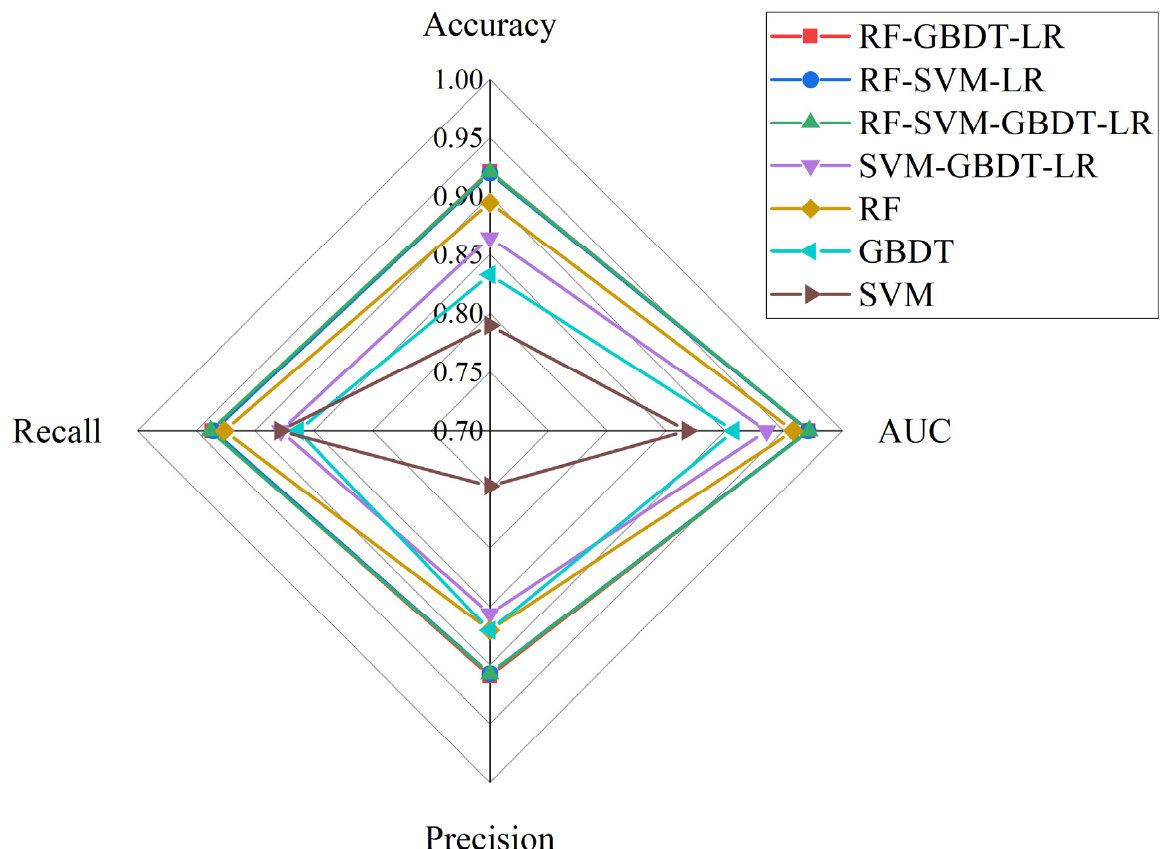
Figure 7. Comparison of model validation results.